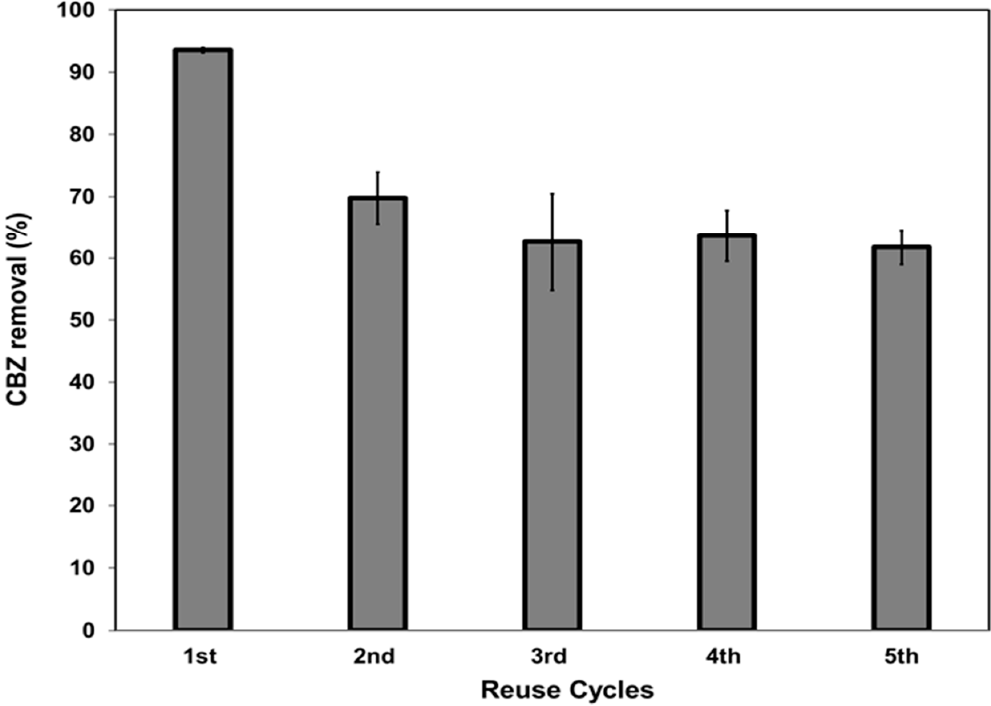
Figure 9. Photocatalytic performance over five cycles (experimental condition: initial CBZ concentration = 5 mg/L; pH = 7; concentration of UiO-66_GO-0.5 = 1 g/L; solution volume V = 50 mL). Plot and error bars represent averages and standard deviations from triplicate experiments.